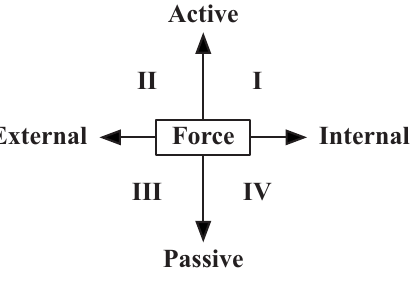
FIG. 2. Dimensions of physicists’ language